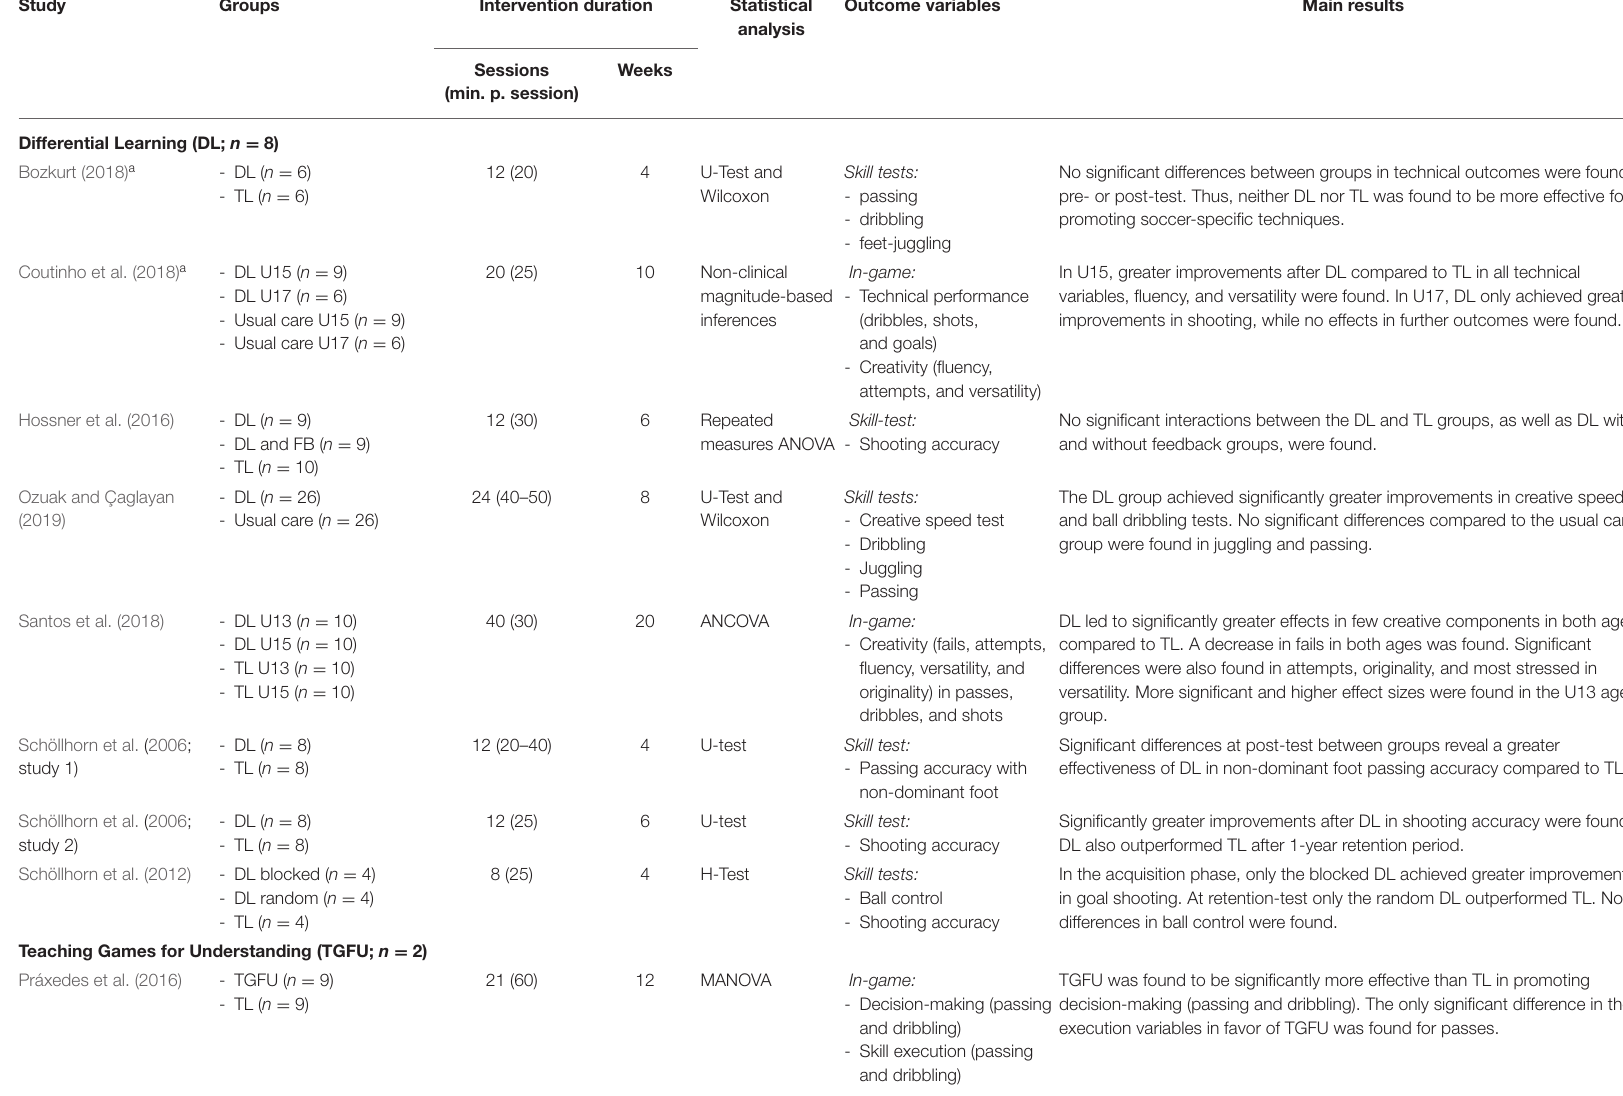
TABLE 5 | Narrative synthesis of the effectiveness of interventions in controlled designs ( n =